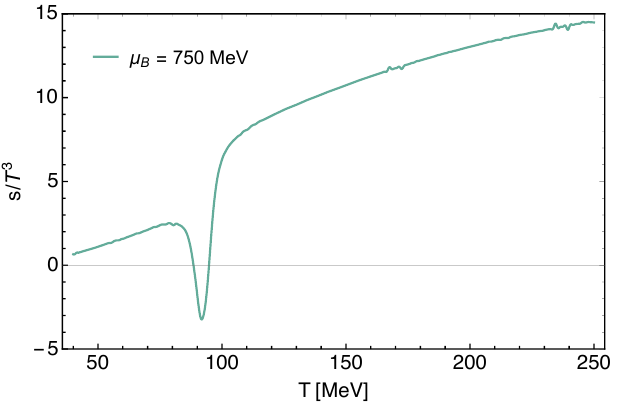
= 750 MeV and µ B